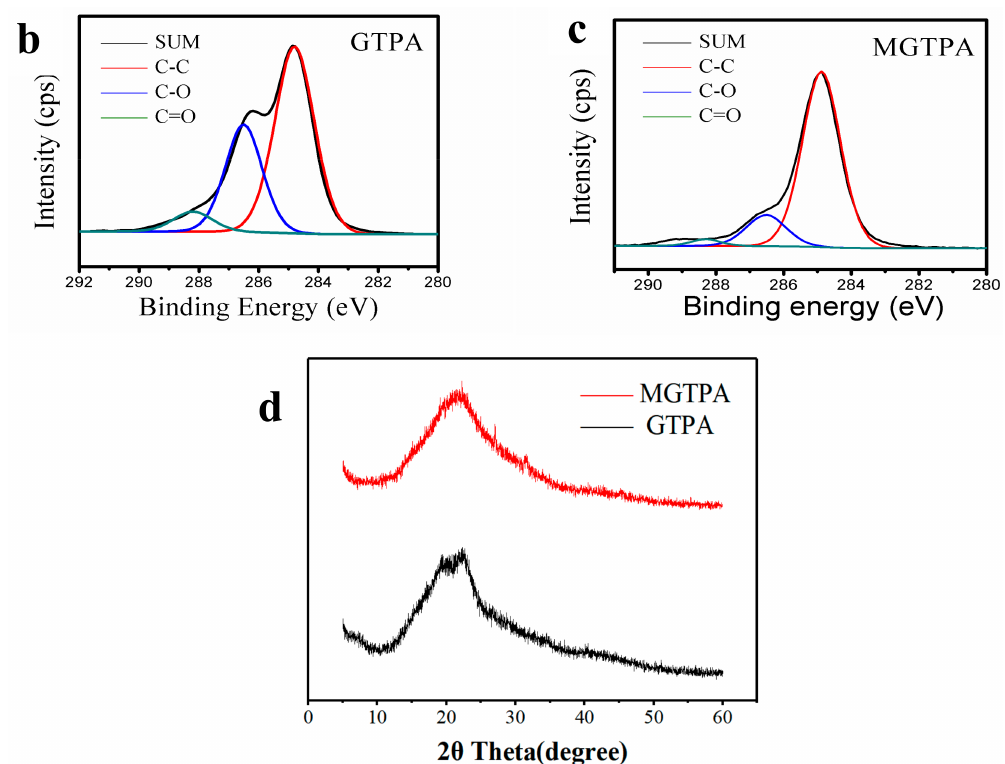
Figure 3. ( a ) Raman spectra of MGTPA and GTPA. XPS high-resolution C1s scans of ( b ) GTPA and ( c ) MGTPA. ( d ) XRD patterns of GTPA and MGTPA.